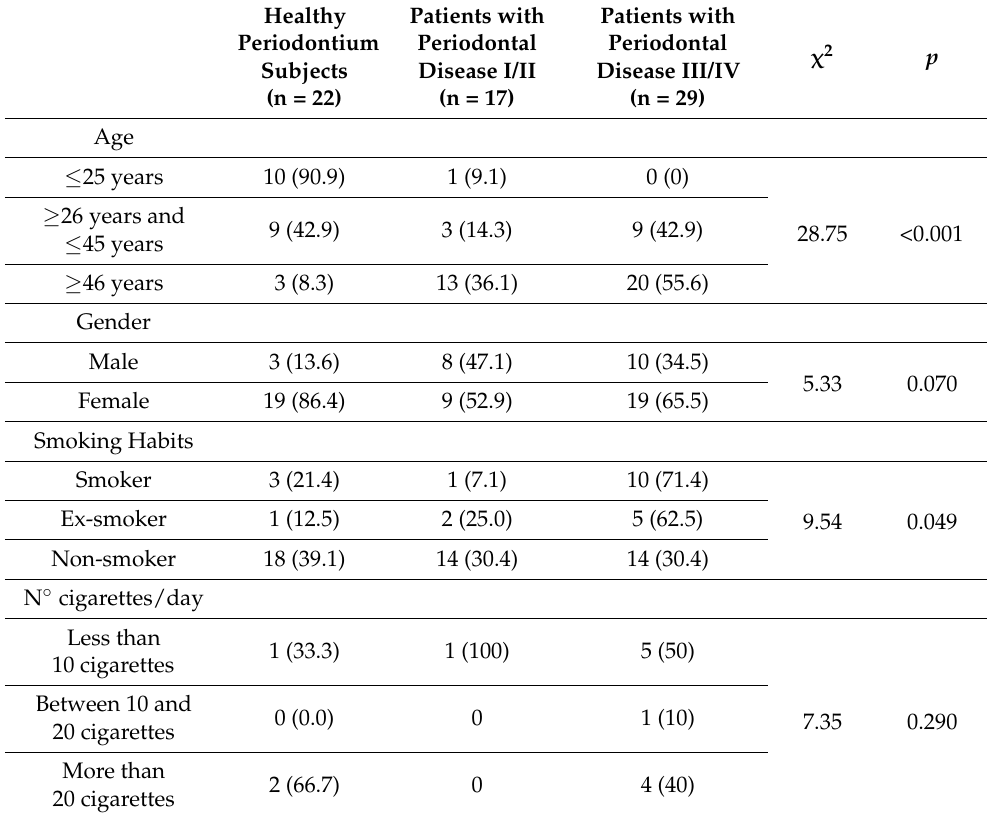
Table 1. Age, gender and smoking habit in healthy and periodontitis stage I/II and III/IV patients.